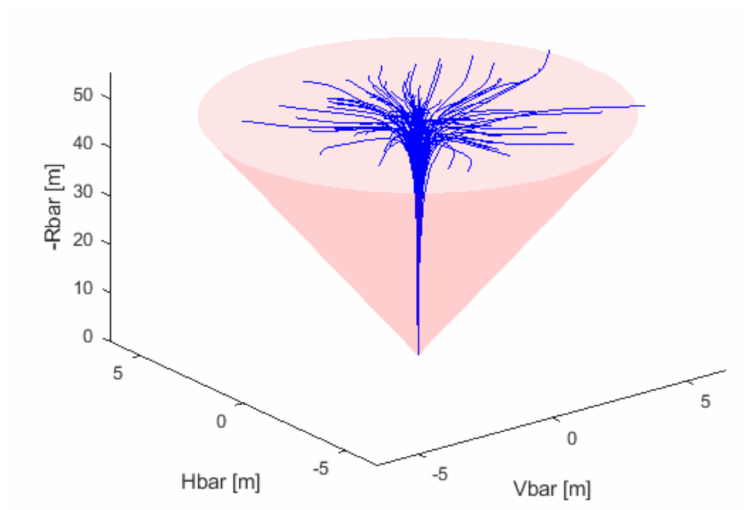
Figure 7. The 3D relative trajectory with the cone constraints.